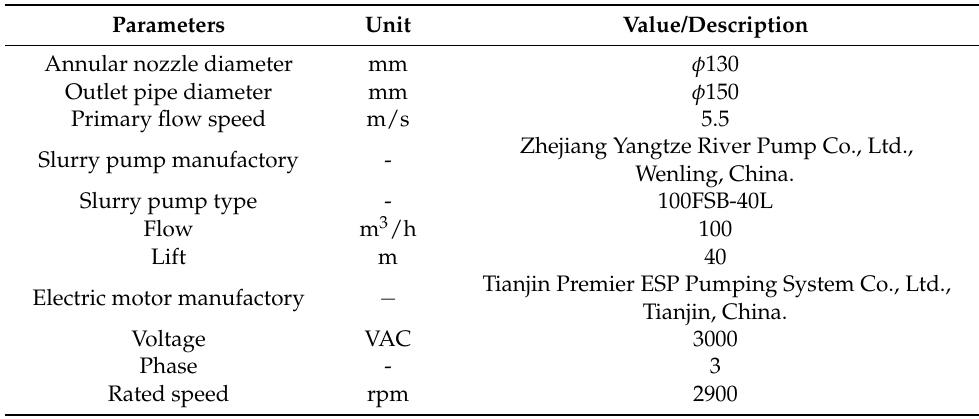
Table 7. Hydraulic collection parameters.